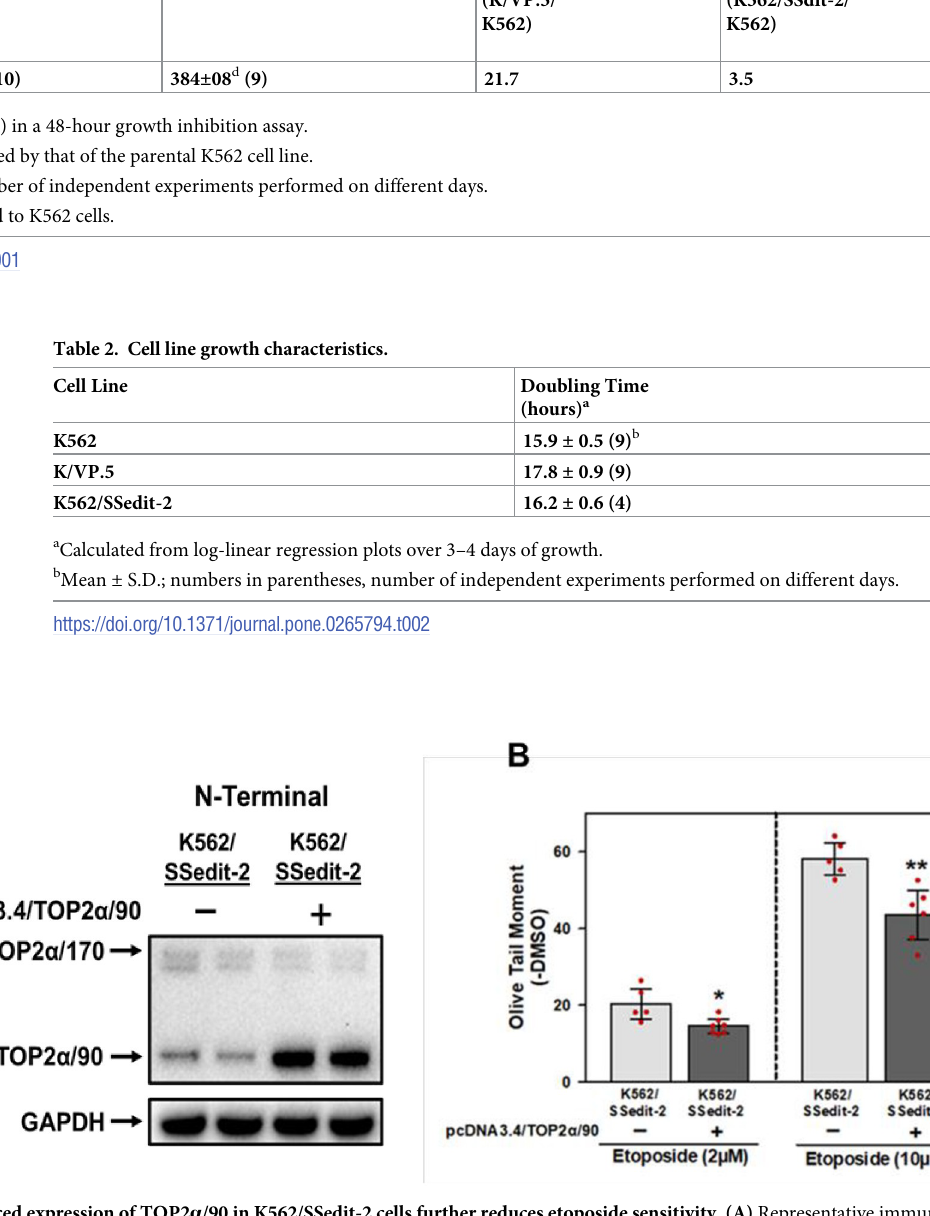
Fig 7. Forced expression of TOP2 α /90 in K562/SSedit-2 cells further reduces etoposide sensitivity. (A) Representative immunoassay using cellular lysates isolated from K562/SSedit-2 mock transfected or K562/SSedit-2 pcDNA3.4/TOP2 α /90 transfected cells. (B) K562/ SSedit-2 mock transfected and K562/SSedit-2 pcDNA3.4/TOP2 α /90 transfected cells were incubated with etoposide (2 or 10 μ M) or DMSO (control) for 30 minutes followed by alkaline (pH 13) Comet assays. Results shown are the mean ± SD for 5 cellular experiments run on separate days. For all experimental conditions in each experiment greater than 100 cells were evaluated by OpenComet software [35]. At 2 μ M etoposide, P = 0.012 comparing the difference in mean values for K562/SSedit-2 pcDNA3.4/TOP2 α /90 transfected vs. K562/SSedit-2 mock transfected cells, 95% CI (-10.01, -1.59). At 10 μ M etoposide, P = 0.003 comparing the difference in mean values for K562/SSedit-2 pcDNA3.4/TOP2 α /90 transfected and K562/SSedit-2 mock transfected cells, 95% CI (-23.05, -6.22). � , P < 0.05; �� , P <